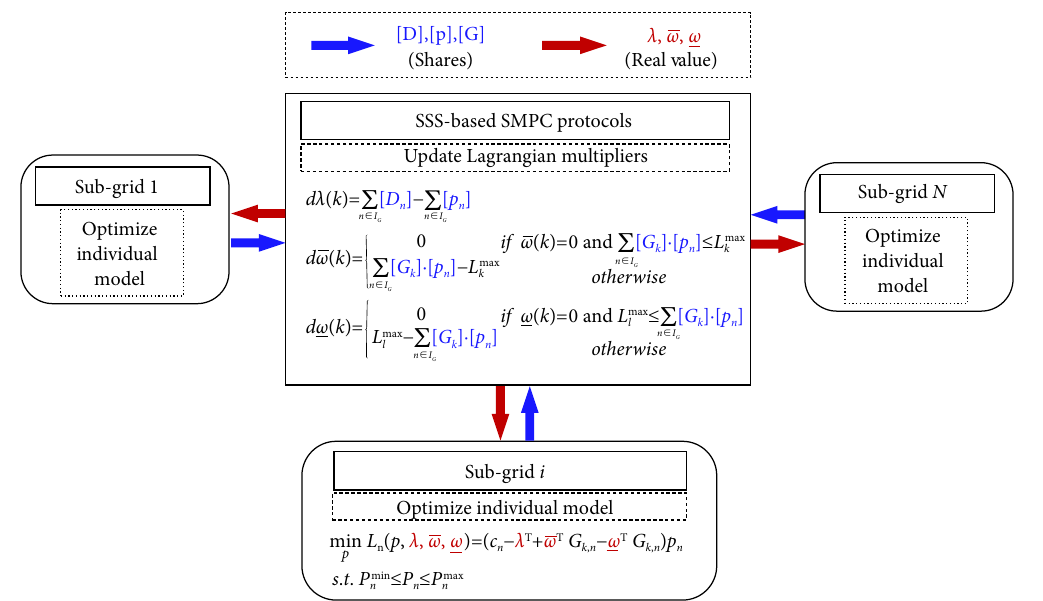
Fig. 7 The SSS-based fully privacy-preserving distributed framework of MAED.